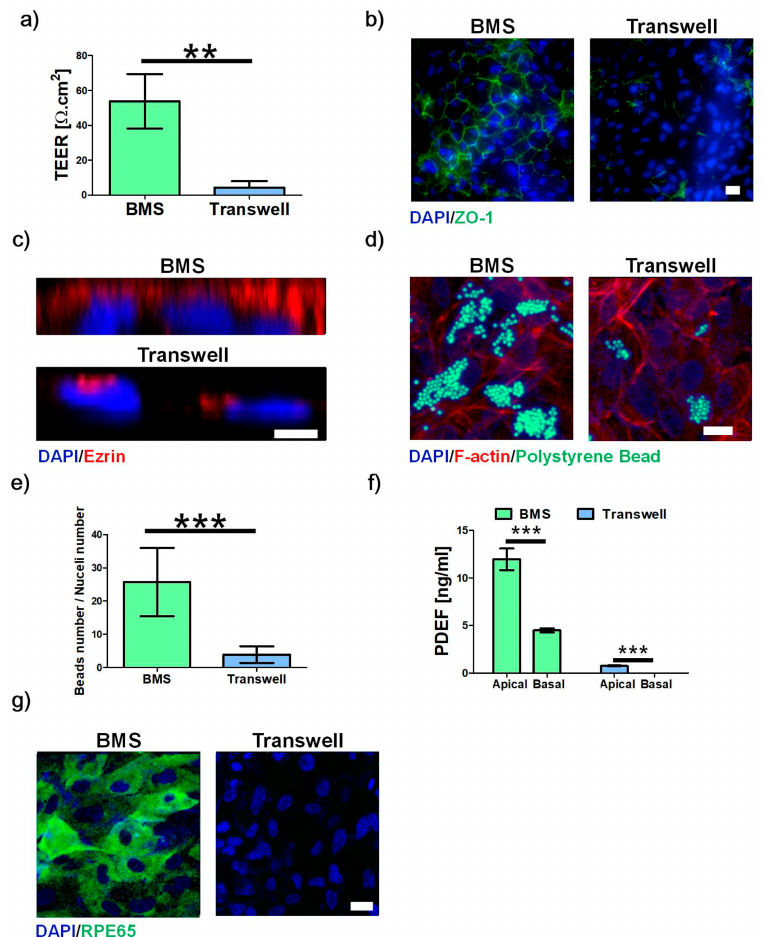
Figure 4. Effect of BMS on RPE maturation. ( a ) TEER value, ( b ) ZO-1 expression for tight junc- tion, ( c ) ezrin expression for microvilli formation, ( d ) digested polystyrene beads for phagocytosis activity, ( e ) counted number of beads to nuclei ratios, ( f ) PEDF secretion for polarized secretion, and ( g ) RPE65 formation for phototransduction in RPE cells on BMS or BM-ECM-coated Transwell (Transwell) at day 10. Scale bars: 20 µ m ( a,c,g ), 5 µ m ( b ). The error bars represent the standard deviation. The data were compared using Student’s t-test and differences were considered significant when ** for p < 0.01, and *** for p < 0.001 ( n =